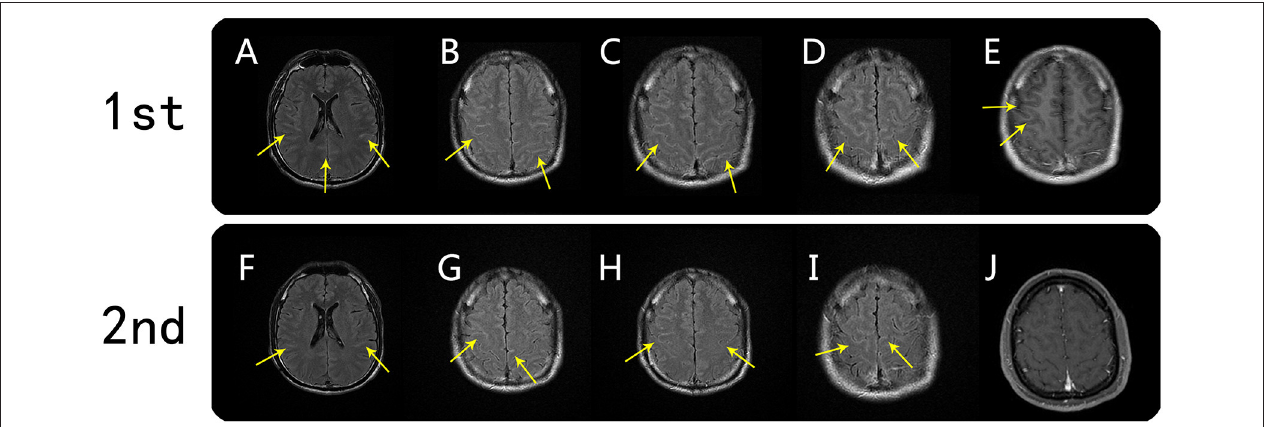
FIGURE 1 | Brain MRI findings from the first and second scans. First MRI scan (on day 2): axial FLAIR hyperintensity was seen in the sulci of the bilateral frontal, temporal, and parietal lobes ( A–D , arrows). Corresponding meningo-cortical enhancement was also seen on axial T1-weighted postgadolinium-enhanced images ( E , arrow). Second MRI scan (on day 7): meningo-cortical lesions on axial FLAIR were mildly regressed, but abnormalities were still observed ( F–I , arrows). T1-weighted postgadolinium-enhanced image showed a corresponding meningo-cortical lesion with no enhancement (J)